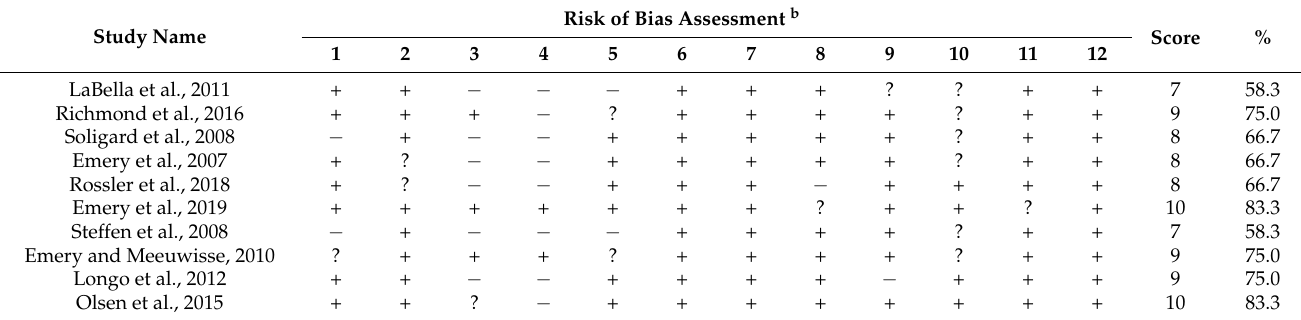
Table 1. Study Quality and Risk of Bias Assessment a